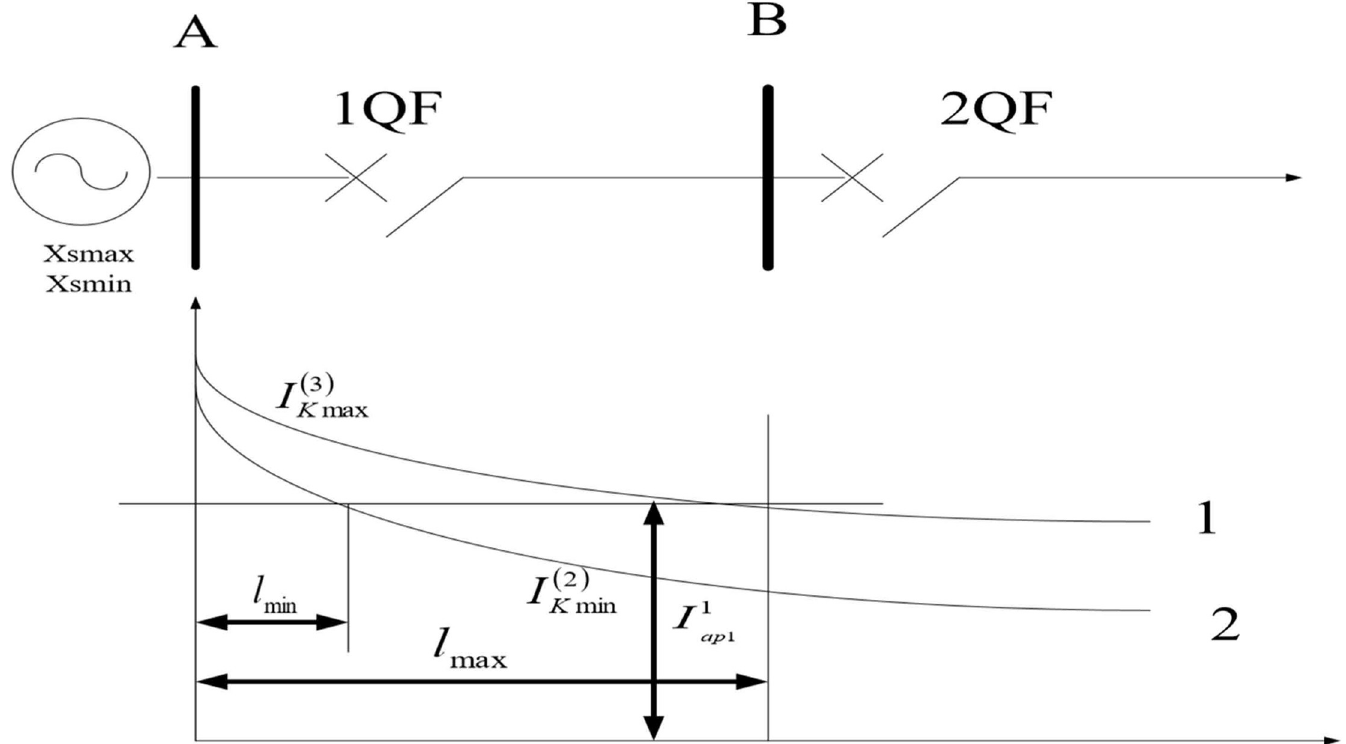
Fig 1. Schematic diagram of setting calculation of instantaneous instantaneous trip protection without time limit.